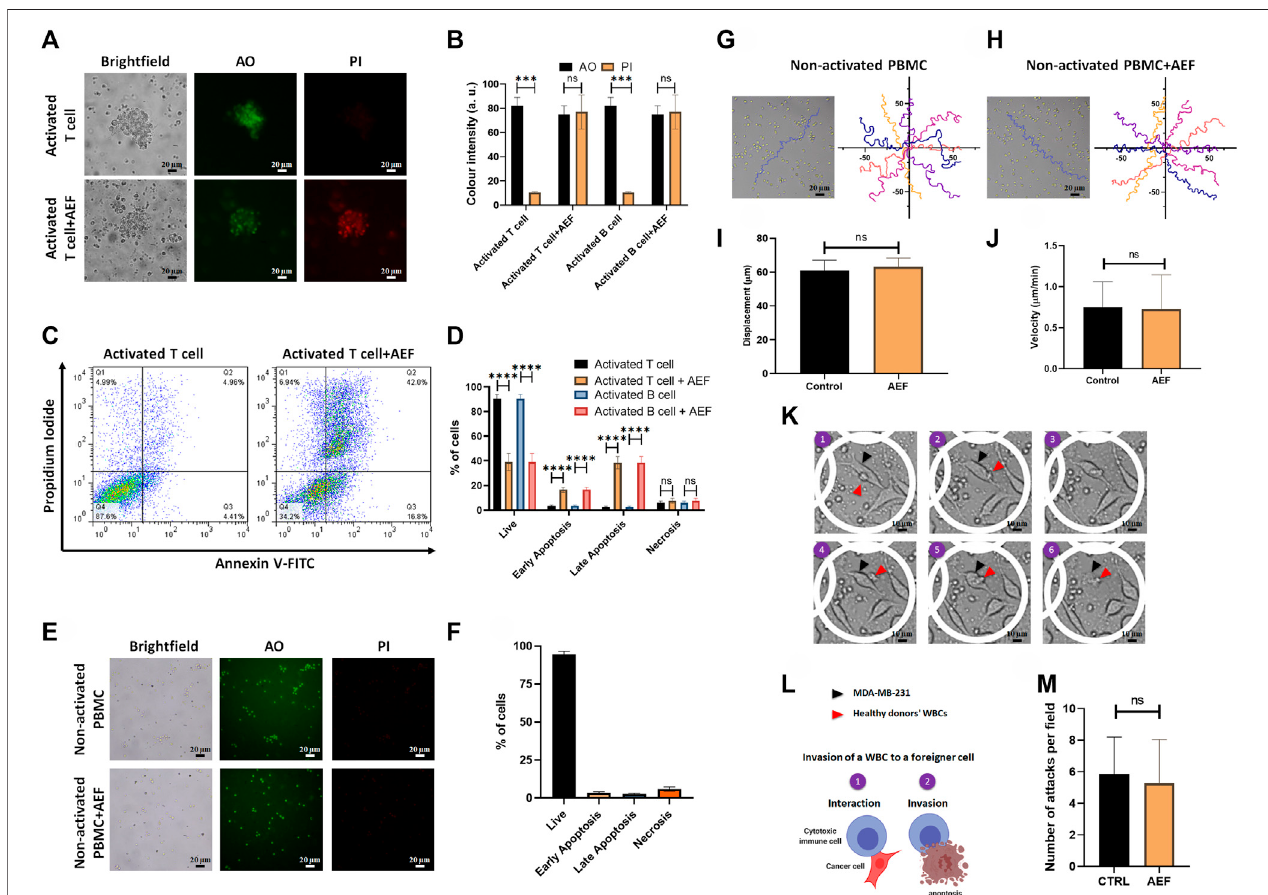
FIGURE3|(A,B) Immuno fl uorescenceimagingshowselevationofPIuptakeinactivatedlymphocytesby48 hofAEFstimulation.PIuptakeinthecontrolgroupis negligible. (C, D) Annexin V/PI assay demonstrated the increase in the percentage of activated lymphocytes in the apoptosis phase caused by AEF. A negligible difference was observed in cells undergoing necrosis in both groups. (E, F) Immuno fl uorescence imaging demonstrates negligible PI uptake in both groups of control andAEF-stimulatednon-activatedPBMCsduetotheeffectivenessofAEFondividingcells. (G,H) Celltrajectorieswereplottedfornon-activatedPBMCsincontrol and AEF-stimulated groups. (I, J) No signi fi cant difference was observed between displacements and velocities in these two groups. (K) Time-lapse imaging on the interaction of the electrically stimulated WBCs from a human donor with MDA-MB-231 cancer cell line. (L) Schematic representation of the WBC invasion to a